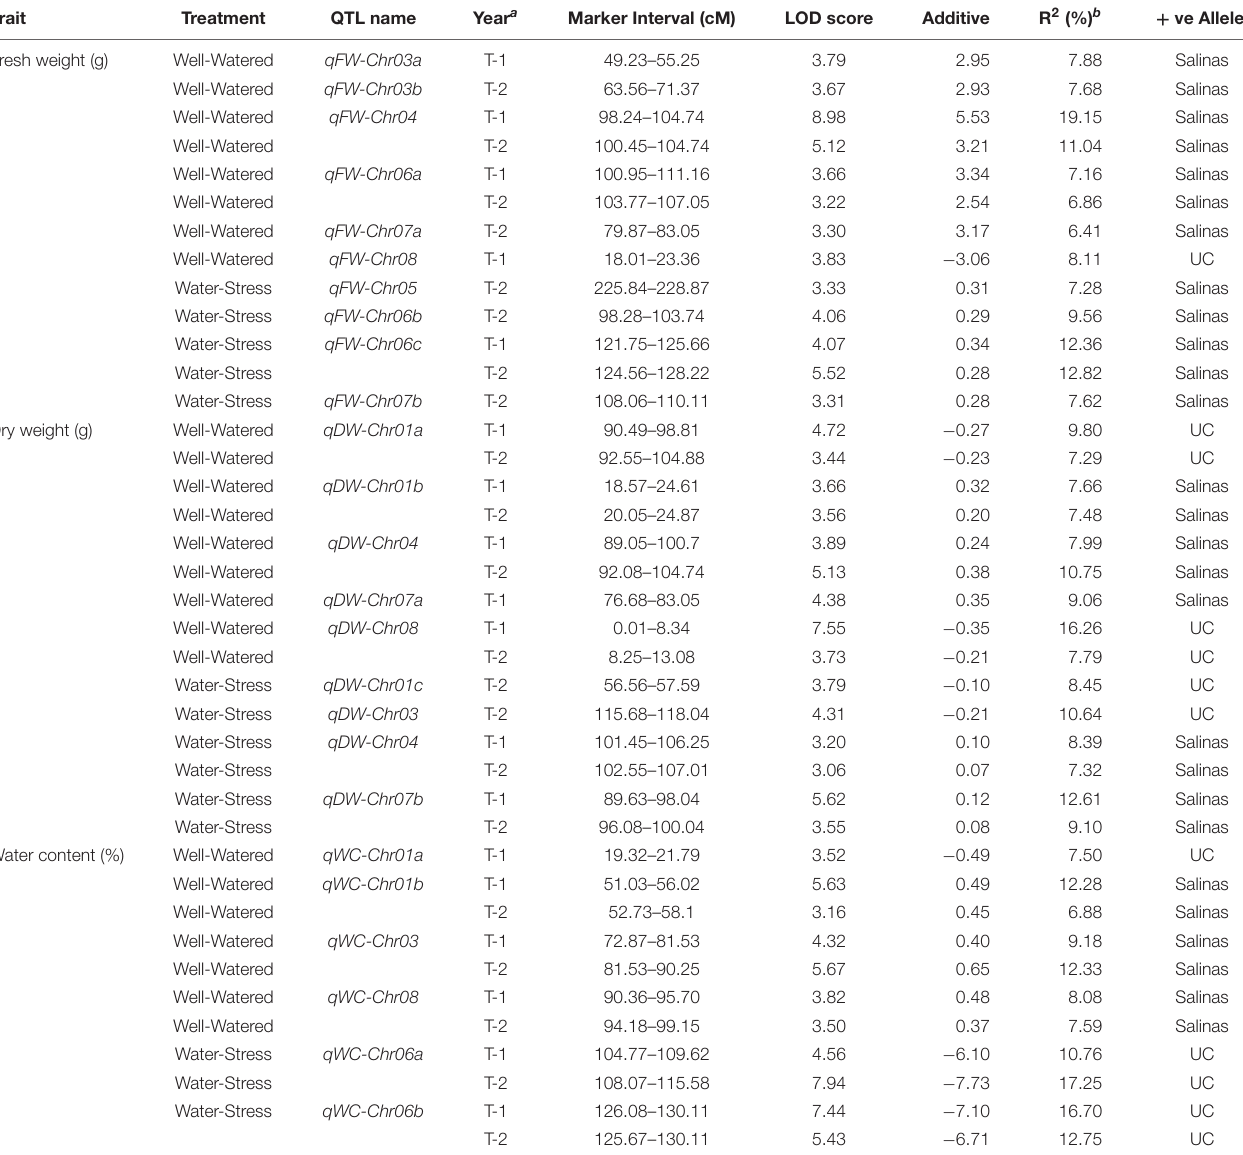
TABLE 4 | Summary of horticultural QTL identified in two trials of the water-stress experiment.